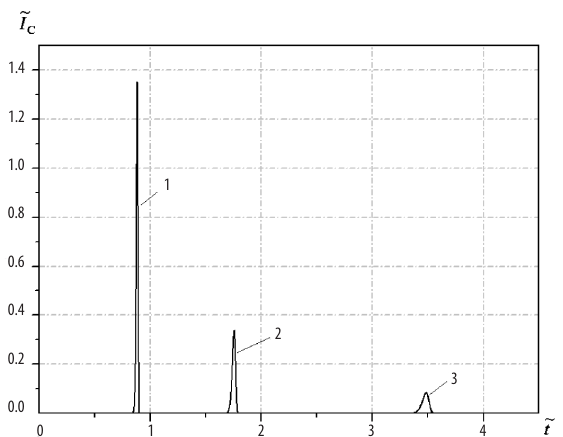
Fig. 3. Dependence of the intensity of acoustic emission ( ) C I t   of x 11 10 − during time on different values of speed of the load’s application χ for the summarizing of displacements. Values